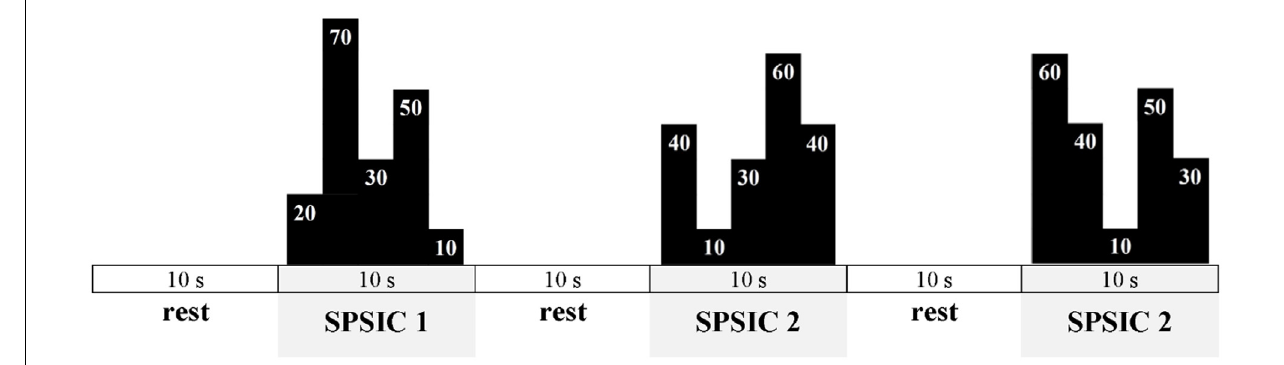
FIGURE 3 | Exemplary scheme of the motor task displayed during tests and training. The final values of UIFA task during each SPSIC are not shown as we would like to ensure the novelty of the task to the participants.